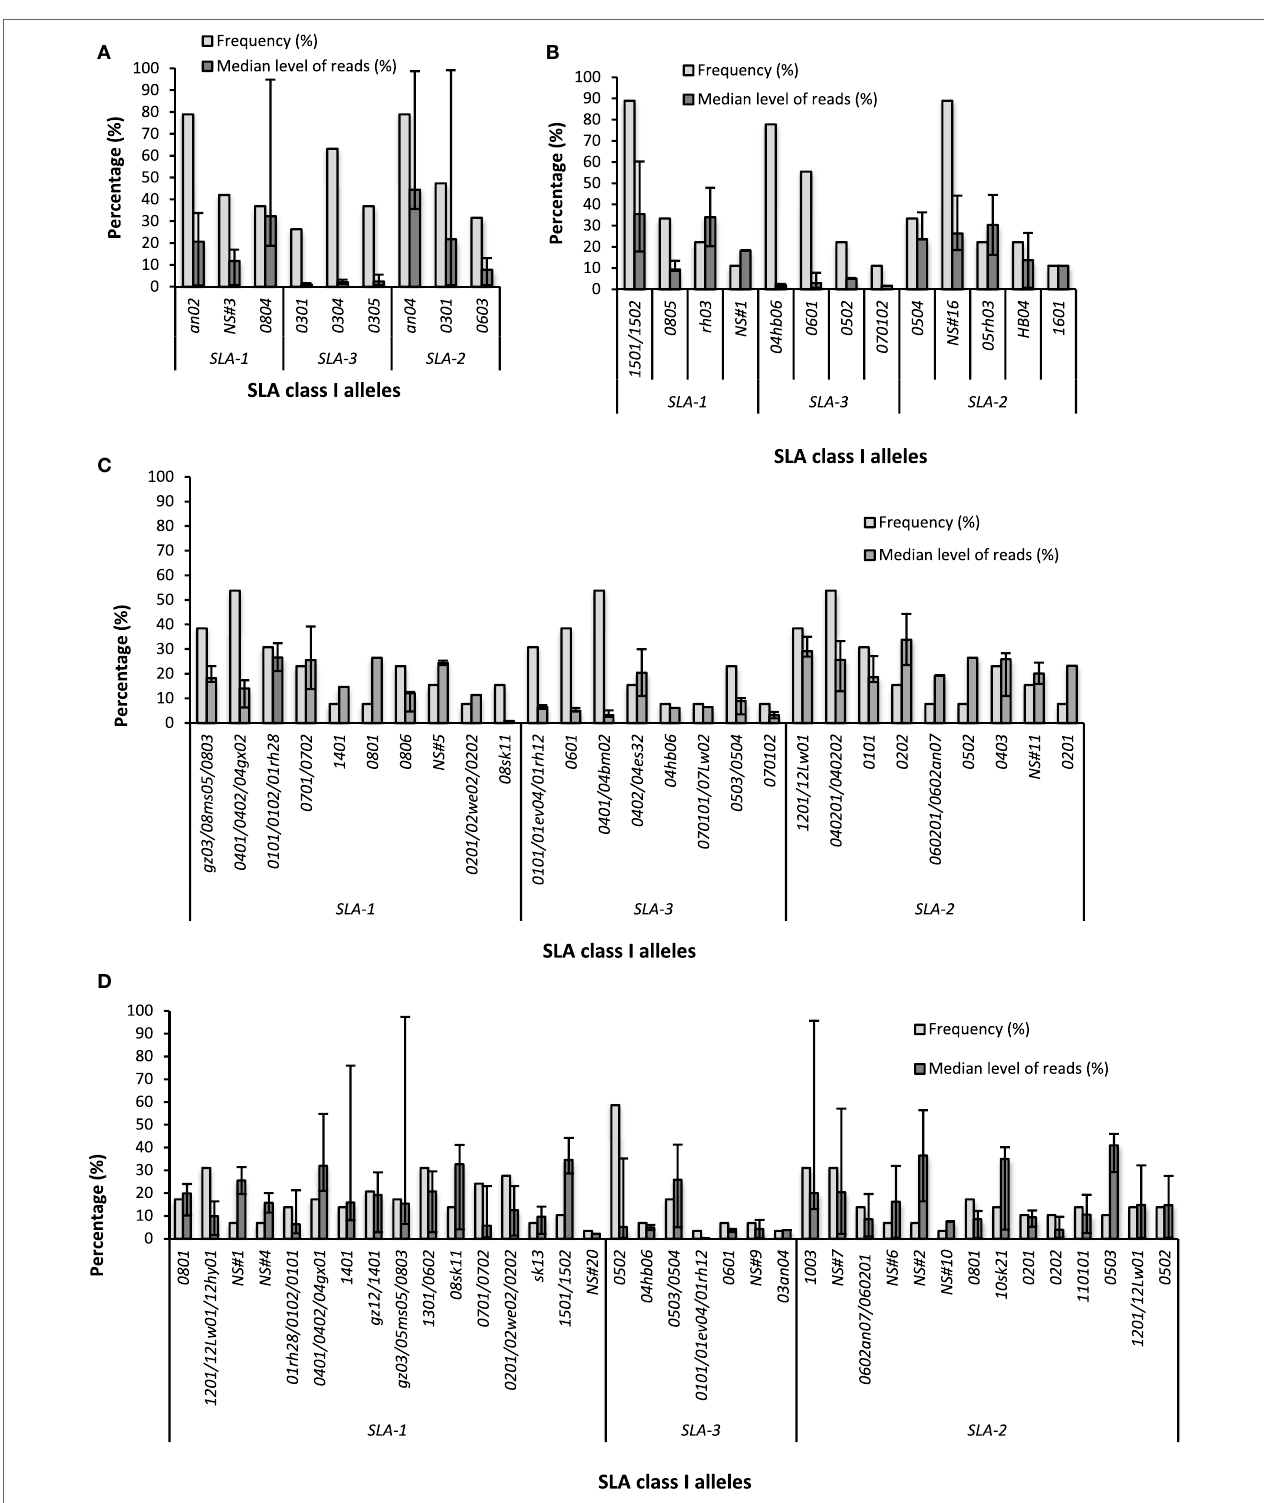
FigUre 2 | Frequencies and levels of sequencing reads for the SLA class I alleles. The identified SLA class I alleles at each of the three classical SLA class I loci in the four different pig populations are shown; (a) Göttingen minipigs ( N = 19), (B) Kenyan pigs ( N = 9), (c) Danish pigs ( N = 13), and (D) Belgian pigs ( N = 29). For each allele, the frequency of animals having the allele (light gray bars) and level of sequencing reads (dark gray bars) are shown here as median value with error bars indicating range of transcription. The SLA-1*an02 allele could not be verified by the PCR-SSP